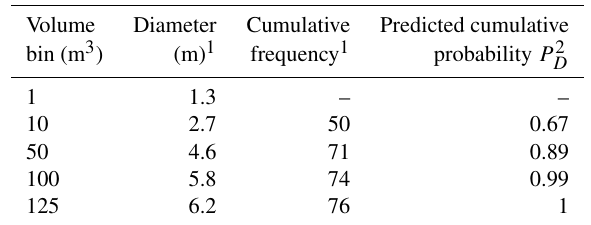
Table 1. Size distribution of the mapped rock blocks ( N =